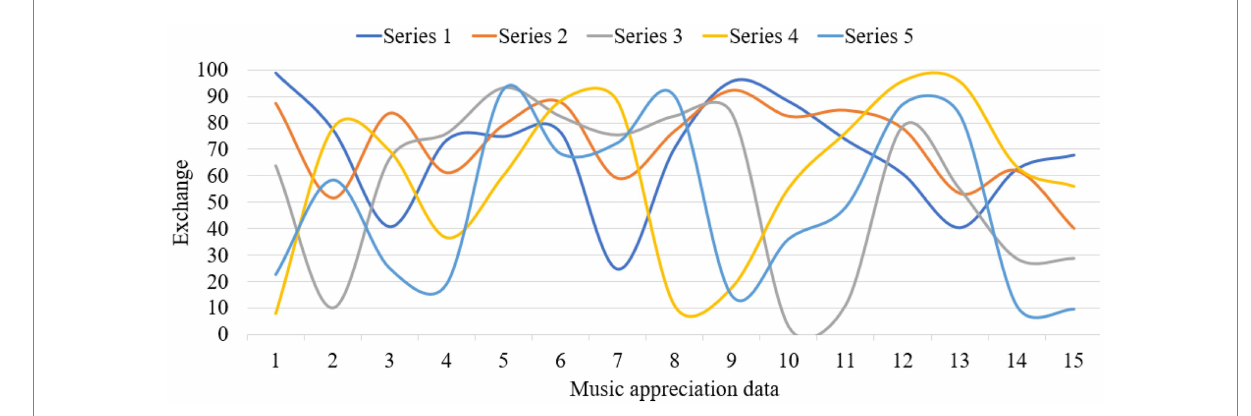
FIGURE 6 Music appreciation data